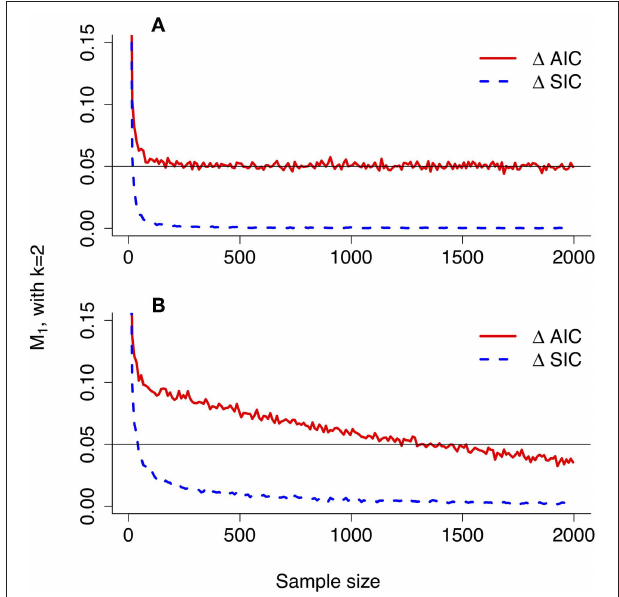
FIGURE 10 | Simulation of Vuong (1989) results for misspecified models. (A) When f 1 ( x , θ 1 ∗ ) and f 2 ( x , θ 2 ∗ ) are the same model (either f 1 is nested within f 2 , or f 1 overlaps f 2 , and the best model is in the nested or overlapping region), then the asymptotic distribution of G 2 is a “weighted sum of chisquares” that does not depend on n . The error probabilities M 1 and W 1 do not decrease to 0 for 1 AIC 12 but do decrease for 1 SIC 12 . (B) When the models are nested, overlapping, or non-overlapping, but a non-overlapping part of f 1 or f 2 is closer to truth, then G 2 has an asymptotic normal distribution with mean and variance that depend on the sample size, and the error probabilities M 1 and W 1 decrease to 0 for both 1 AIC 12 and 1 SIC 12 . Details of these two settings in (A,B) are found in a fully commented R